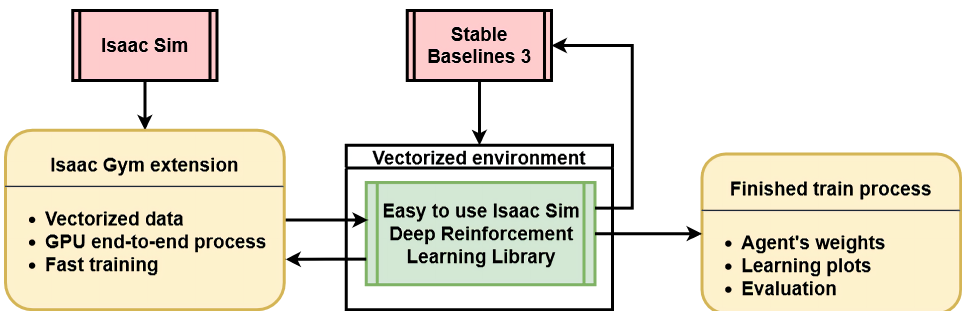
Figure 3. A general overview of how the library interacts with the Isaac Gym extension and Stable Baselines 3 to train an expert